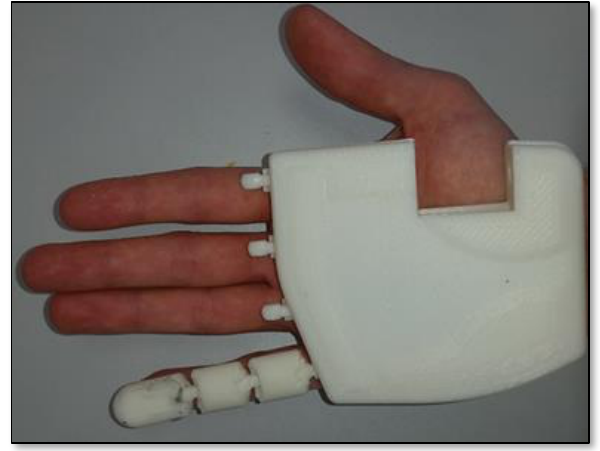
Figure 7. – Hand assembly (1).